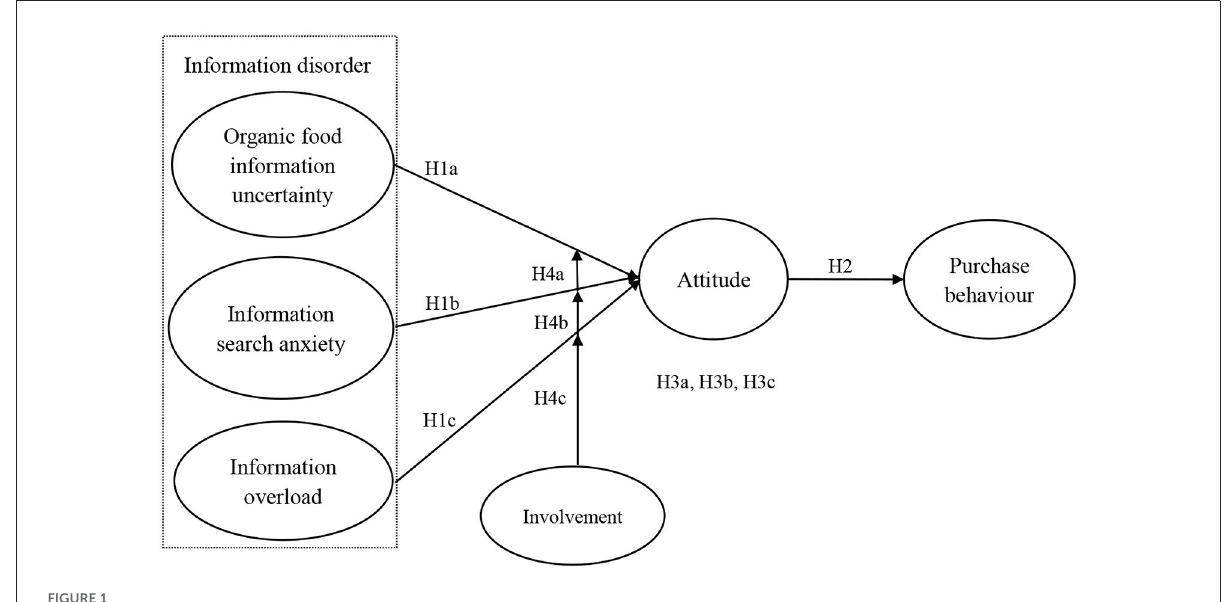
FIGURE1 The hypothesized